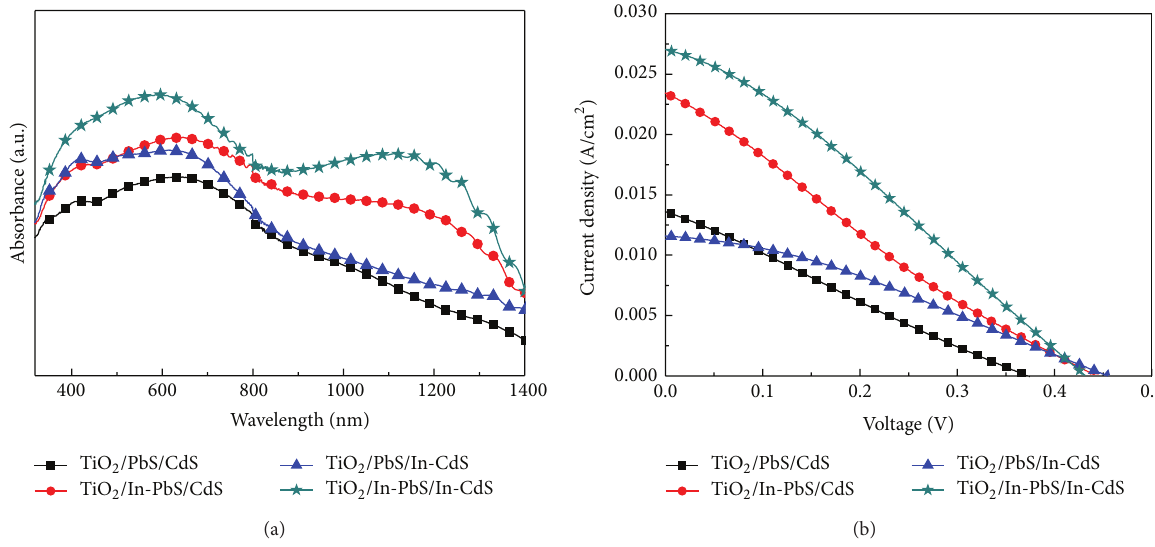
Figure 4: (a) Diffuse reflectance absorbance spectra of different QD sensitized films; (b) 𝐽 - 𝑉 characteristics of different working